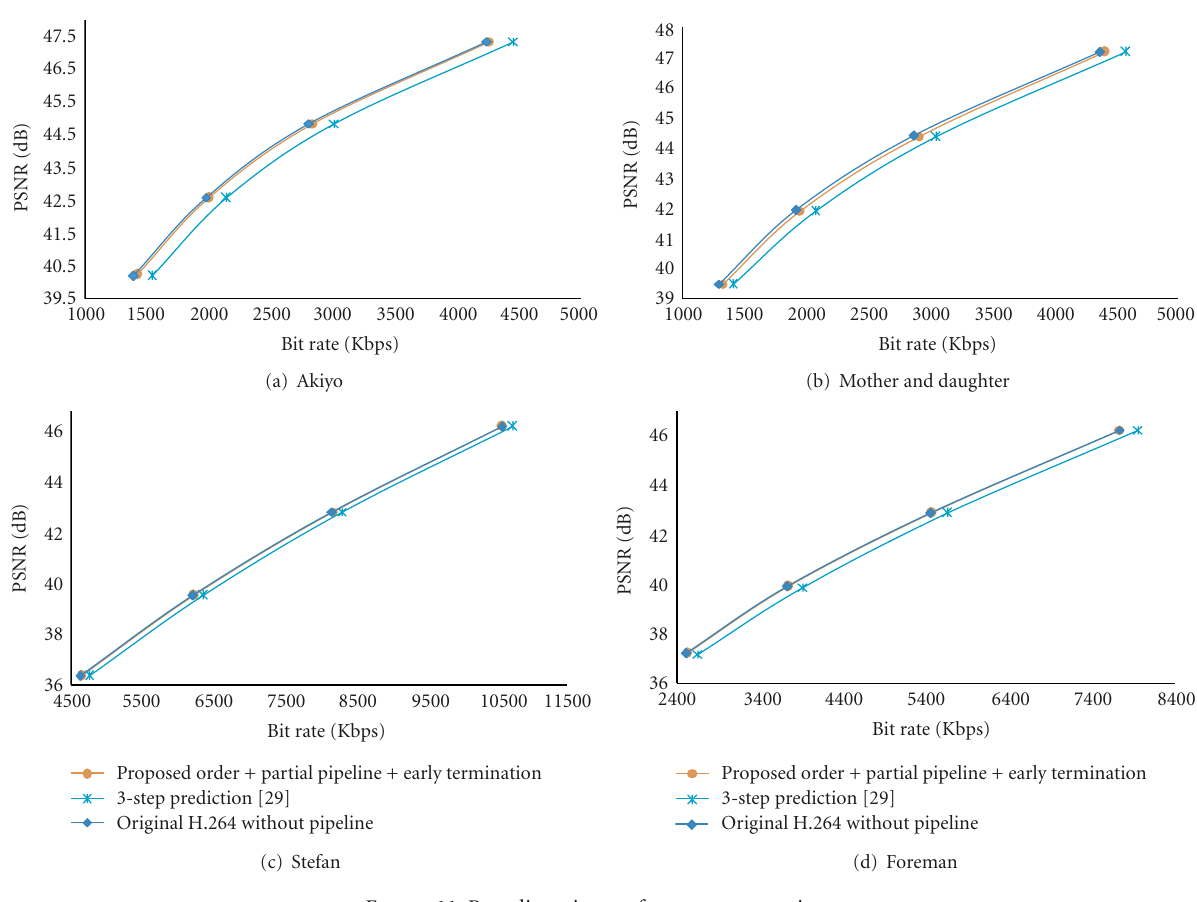
Figure 11: Rate distortion performance